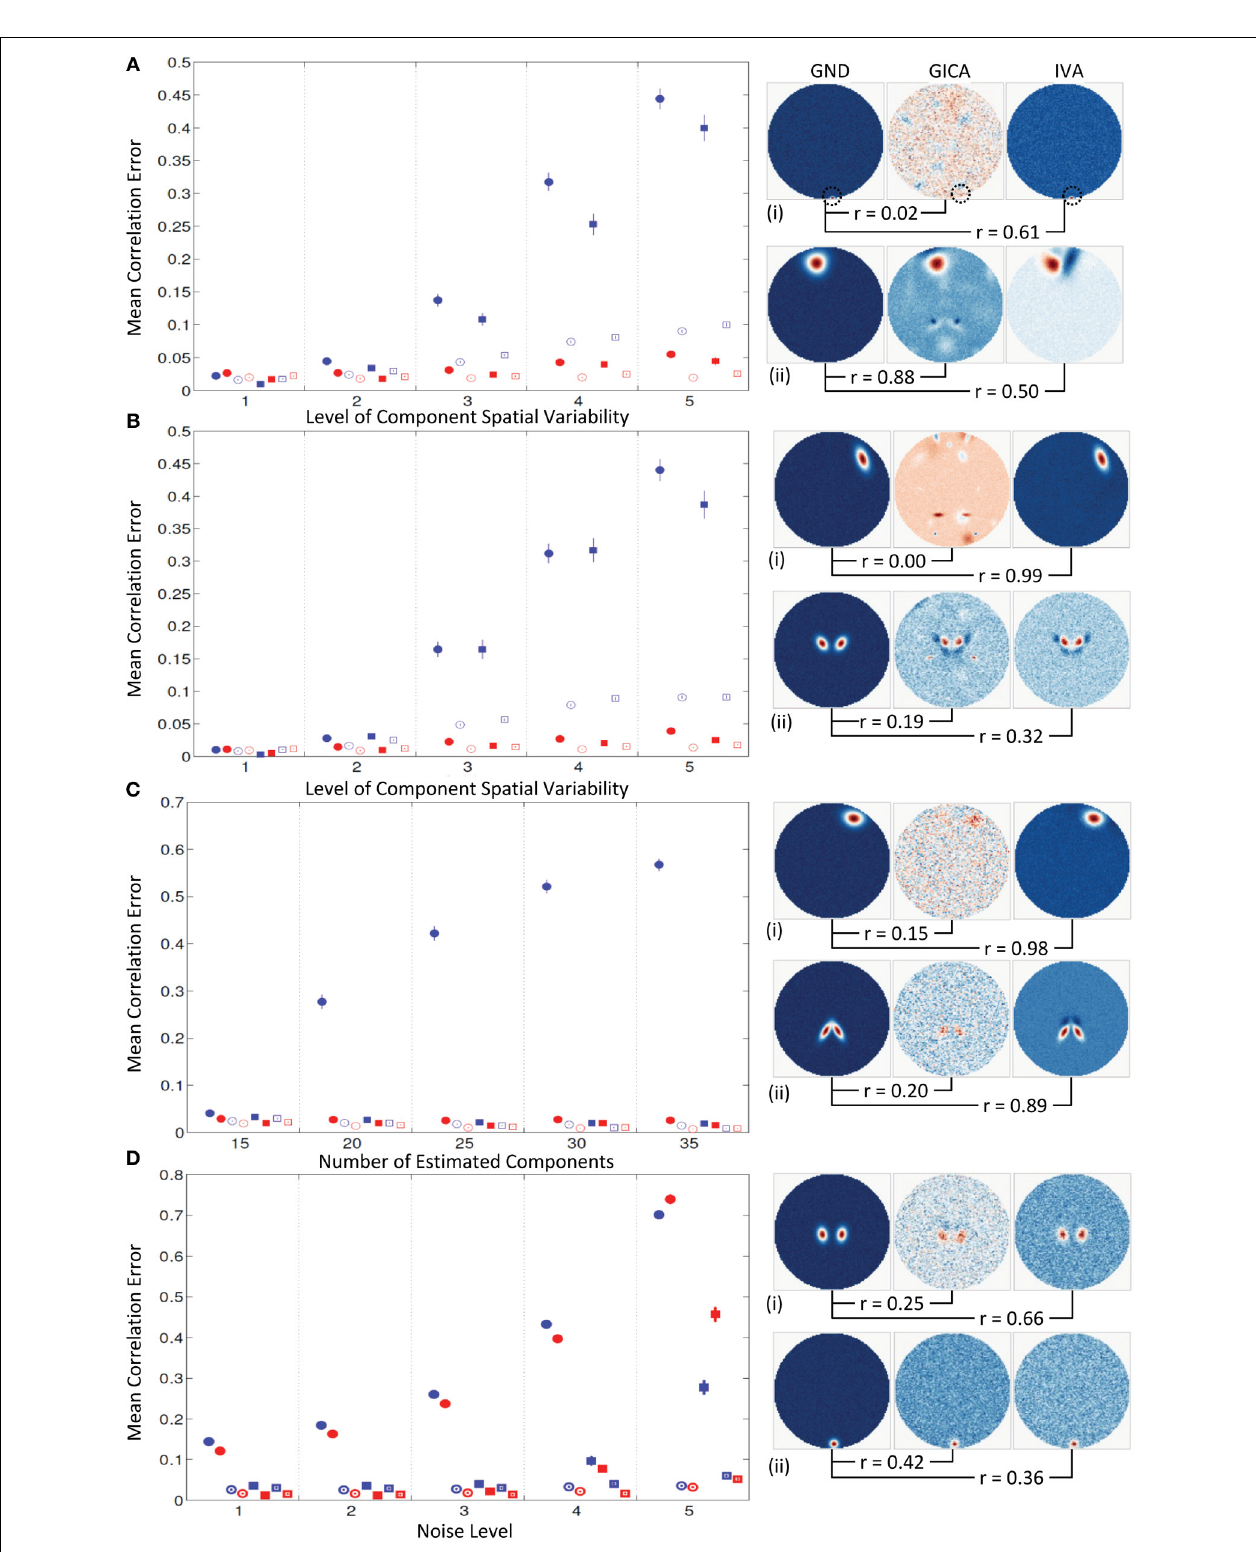
FIGURE 8 | Results of Experiment 4: Results from a larger dataset with higher number of subjects and components and with variability in all components. In this experiment all components of all subjects undergo a combination of variability. Correlation errors reported here are mean values